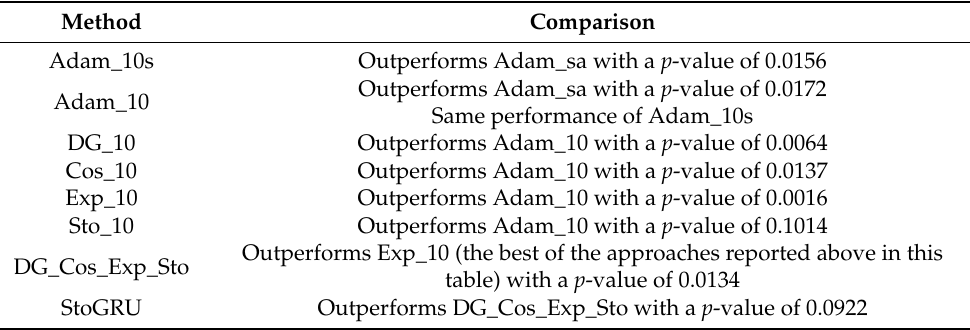
table) with a p -value of 0.0134